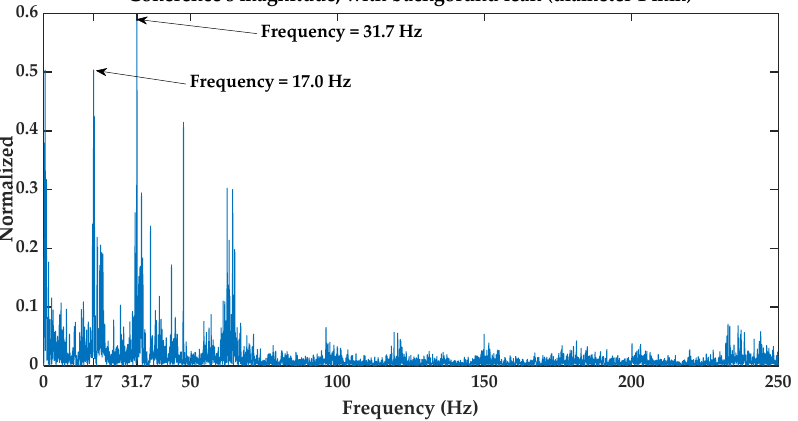
Figure 11. Coherence’s magnitude, with background leak ( 1 mm in diameter) and flow rate 33.7 mL/s.